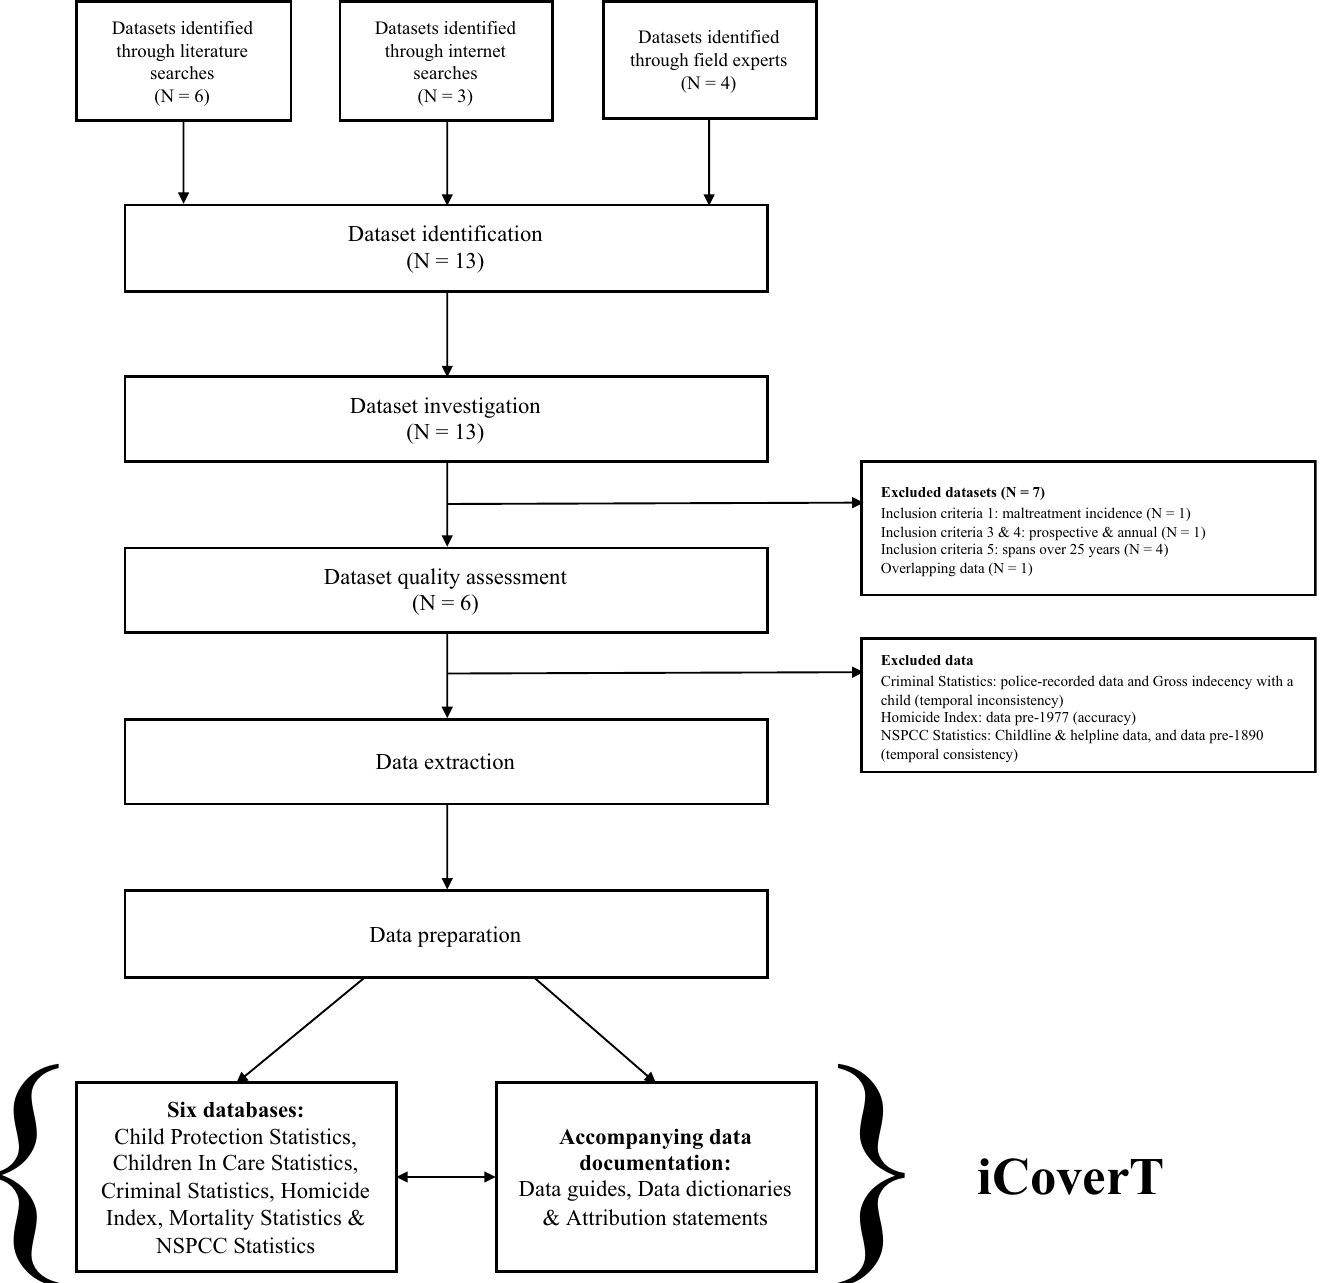
Fig 1. Schematic diagram illustrating the process of developing the iCoverT.